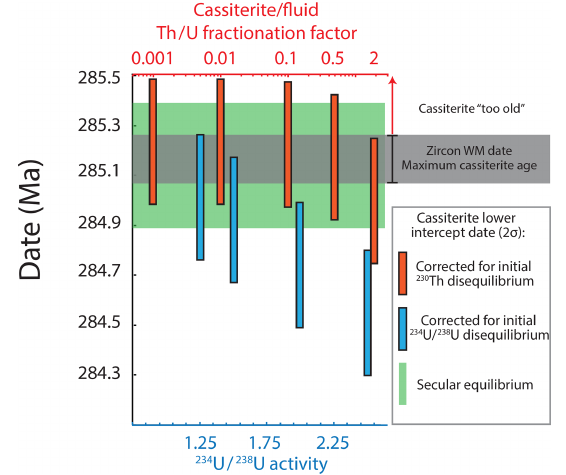
Figure 9. Effects of corrections for initial intermediate daughter disequilibrium on the lower intercept date of C1.1 regression over geologically feasible parameters. Note that corrections are treated independently and that combinations of initial disequilibrium ef- fects could be present. The maximum possible age of cassiterite is defined by the zircon age and the uncertainty of the porphyritic granite stock that hosts the cassiterite-bearing veins. See the text for discussion.